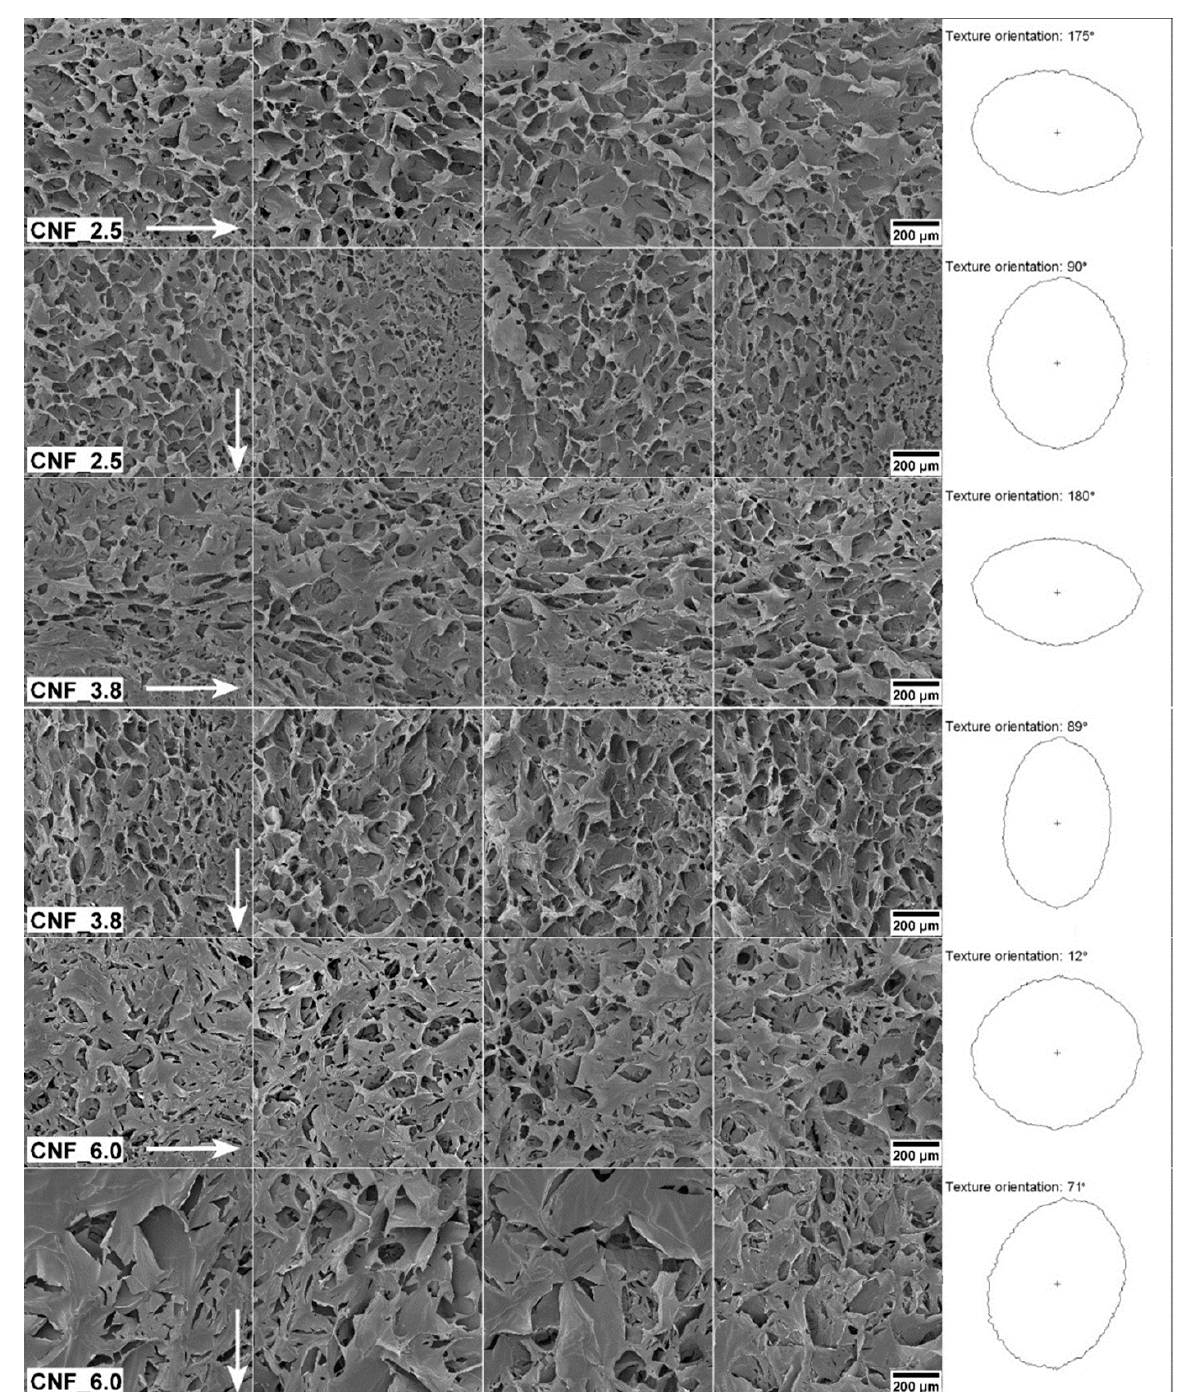
Figure 5. SEM assessment of freeze-dried constructs. The four columns provide four replicate SEM images for each series. The arrows indicate the printing direction. The right-column polar plots illustrate the main orientation of the surface structure.